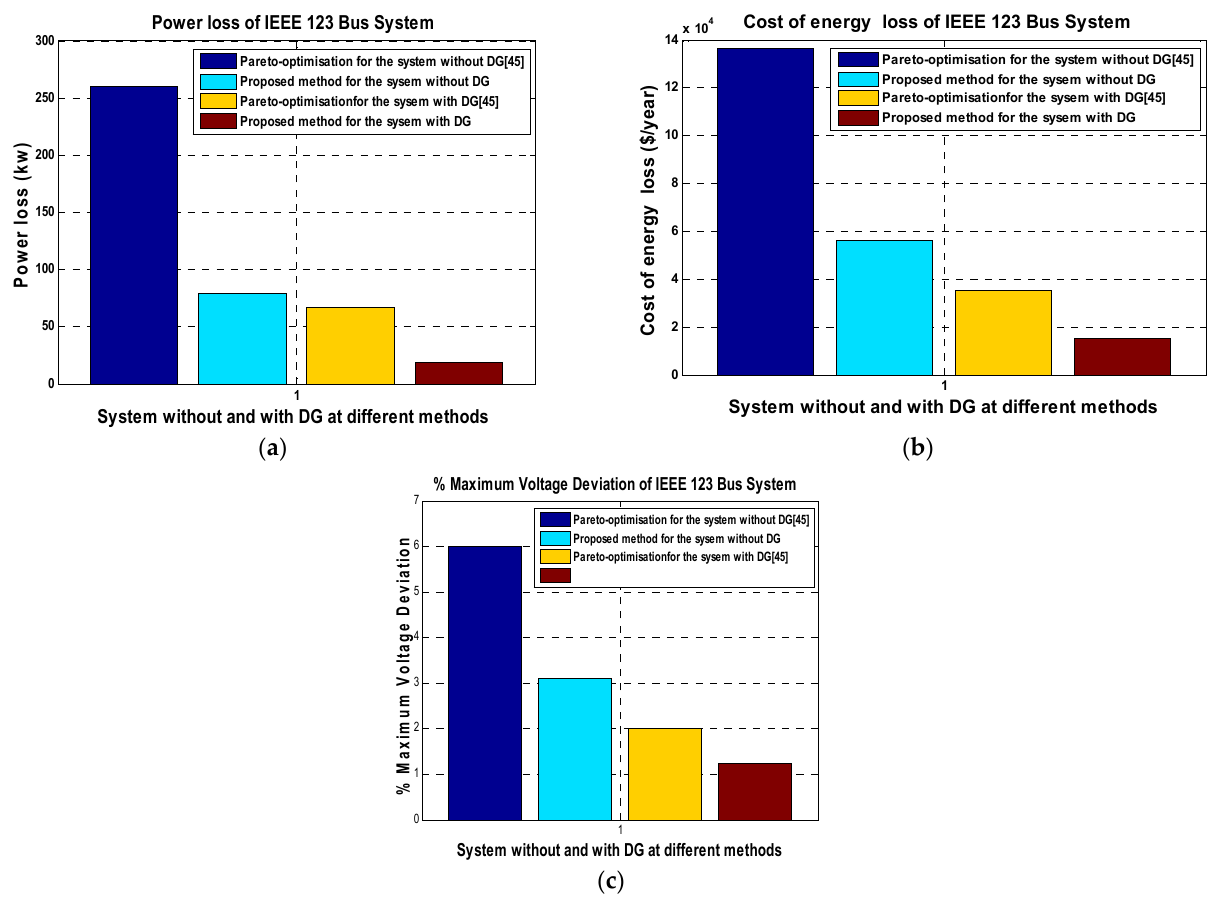
Figure 8. Comparison between the IEEE 123 unbalanced system using the proposed method and the best previous methods: ( a ) Power losses in kW ; ( b ) Cost of energy losses savings in $; ( c ) Maximum voltage deviation .